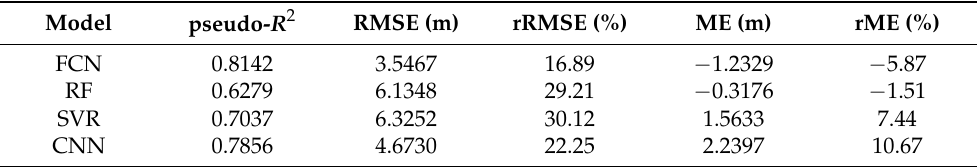
Table 1. Comparison of the error metrics for the different canopy height models: FCN, RF, SVR, and